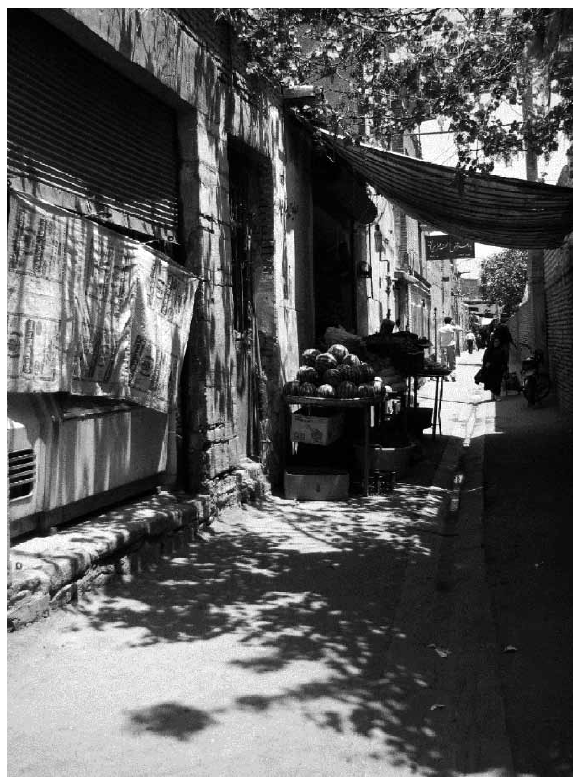
fig. 6. narrow alleys in old district of Shiraz (photo by the author)